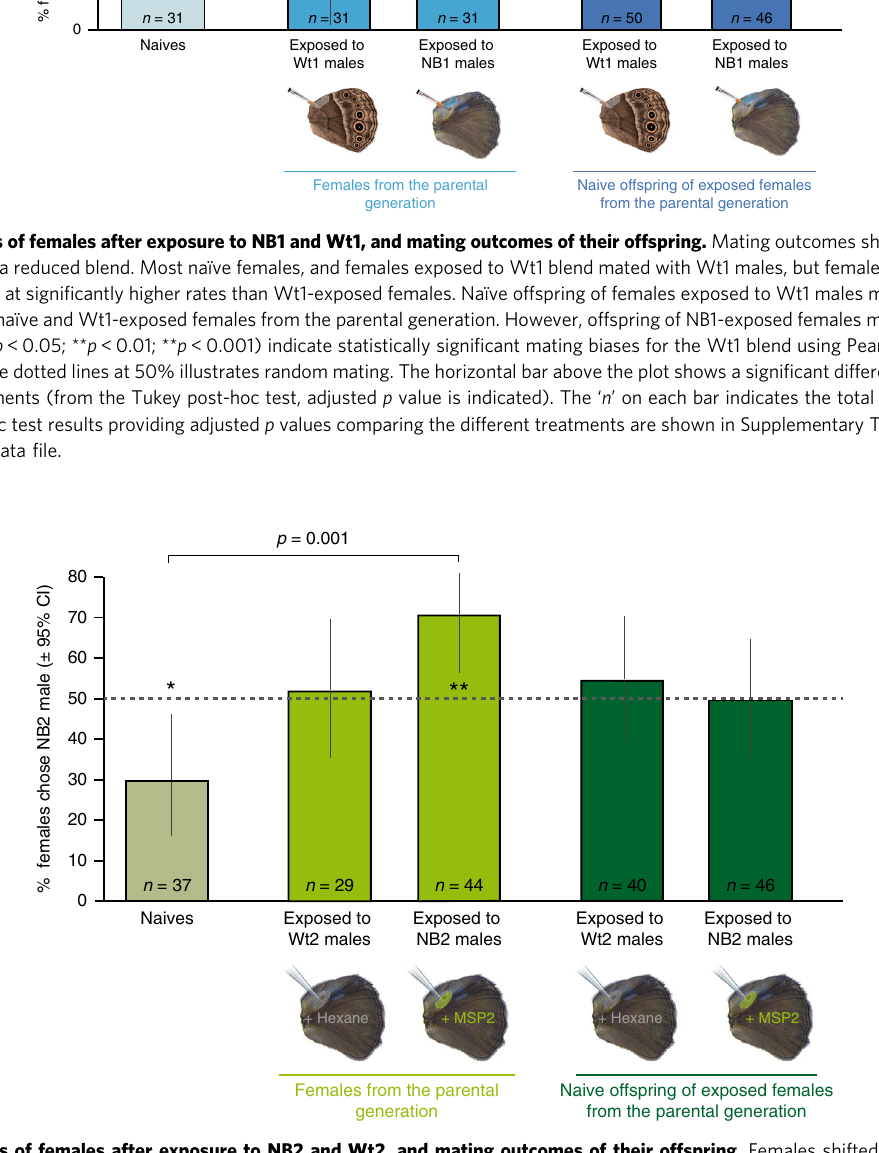
Fig. 3 Mating outcomes of females after exposure to NB2 and Wt2, and mating outcomes of their offspring. Females shifted their mating outcomes after exposure to a Wt2 male or a male perfumed with a novel pheromone blend containing more MSP2. Most naïve females mated with Wt2 males, females exposed to the Wt2 blend mated equally with both male types, and females exposed to the NB2 blend mated with NB2 males at signi fi cantly higher rates than naïve females. Naïve offspring of females exposed to Wt2 and to NB2 males mated equally with either male type but mated with NB2 males more frequently than naïve butter fl ies of the previous generation. The dotted lines at 50% illustrates random mating. Asterisks (* p < 0.05; ** p < 0.01) represent signi fi cant mating biases tested with Pearson ’ s χ 2 tests. CI means con fi dence intervals. The horizontal bar above the plot shows a signi fi cant difference in mating outcome between the two designated treatments (from the Tukey post-hoc test, adjusted p value is indicated). The ‘ n ’ on top of each bar indicates the total number of independent females tested. Post-hoc test results providing adjusted p values comparing the different treatments are shown in Supplementary Table 1b. Source data are provided as a Source Data fi